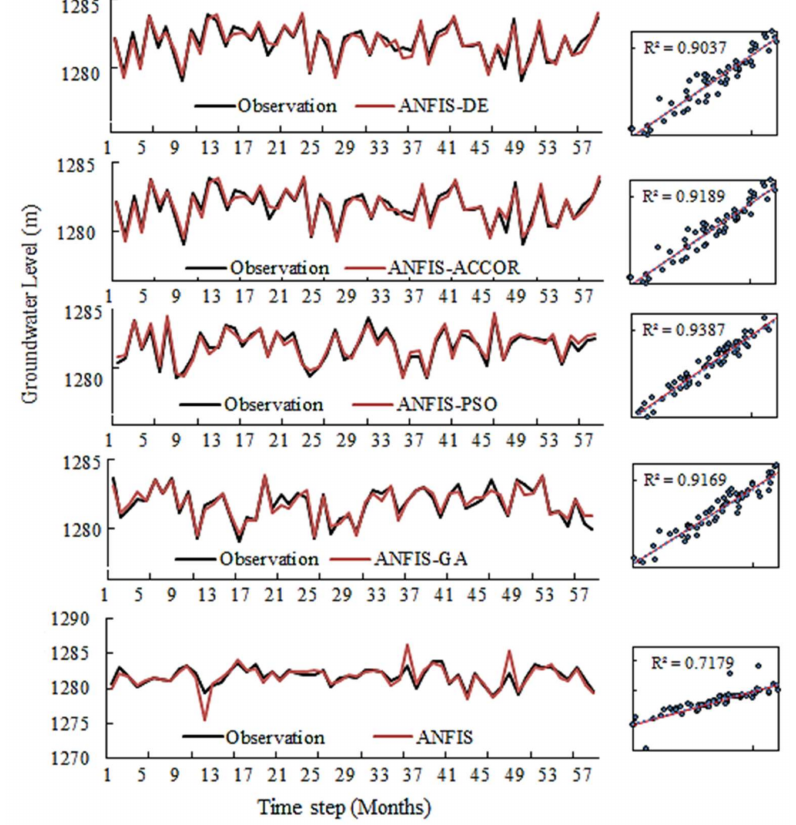
Figure 6. Observations and predictions for well